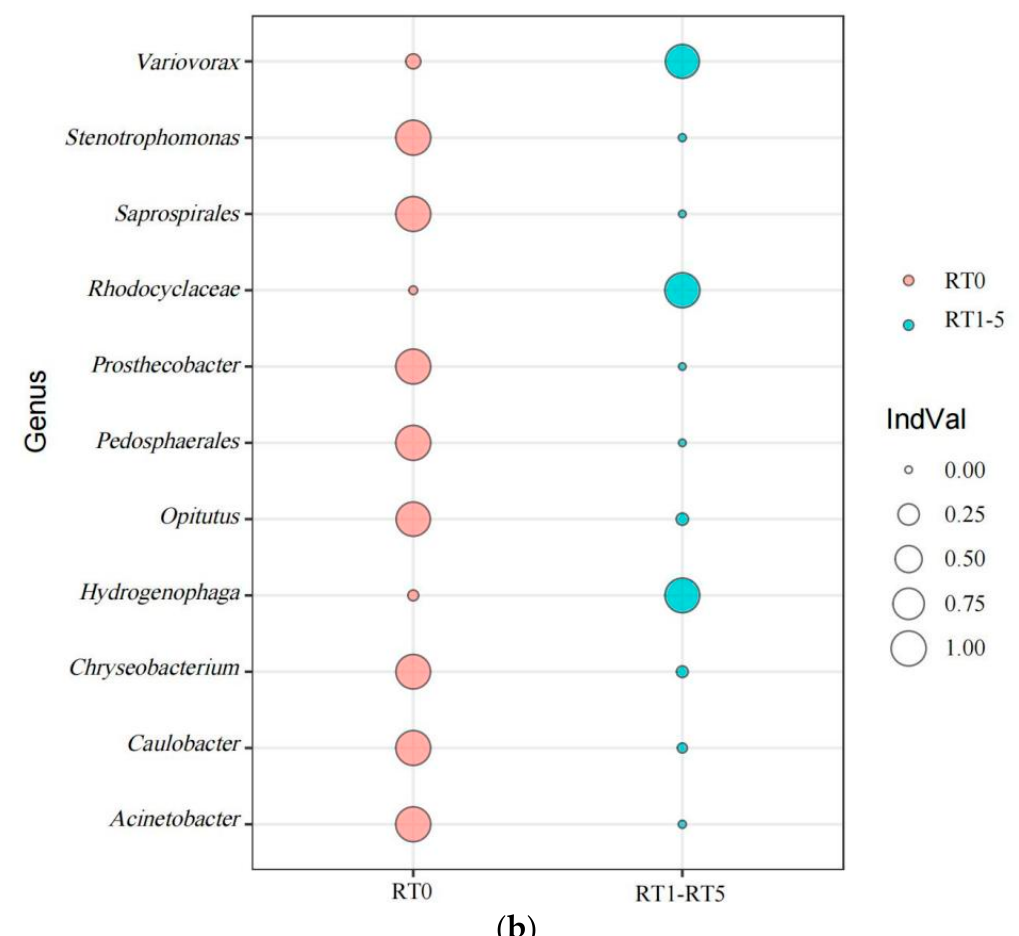
Figure 1. Key players involved in phenanthrene degradation. RT0, phenanthrene-consuming en- richment culture. RT1–RT5, phenanthrene-consuming subcultures. ( a ) Dynamics of phenanthrene- consuming bacterial communities derived from Antarctic soil. The relative abundance of the top 10 most abundant genera is presented. ( b ), Differentiation of key taxa enriched from phenanthrene- consuming subcultures derived from Antarctic soil. Differentiated genera of the phenanthrene- spiked communities by cross-validation analysis. The Y-axis denotes the differentiated taxa of the phenanthrene-spiked communities. The X-axis denotes different treatments. The circle size denotes the indicator value of the corresponding microbial taxa.